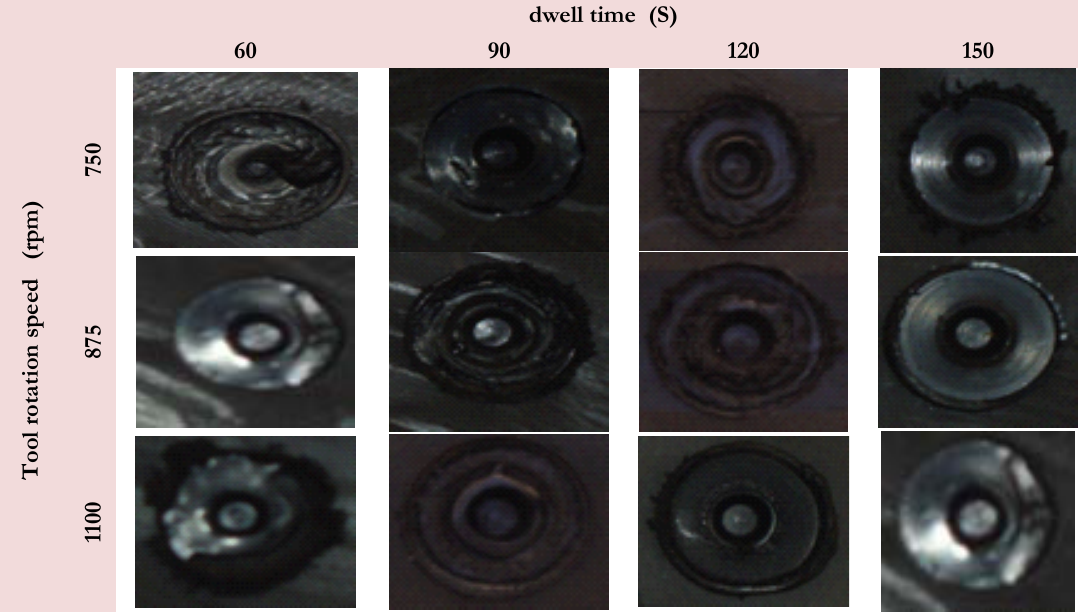
Table 3: Joint production form on upper sheet after friction stir spot welding at different parameters Tensile